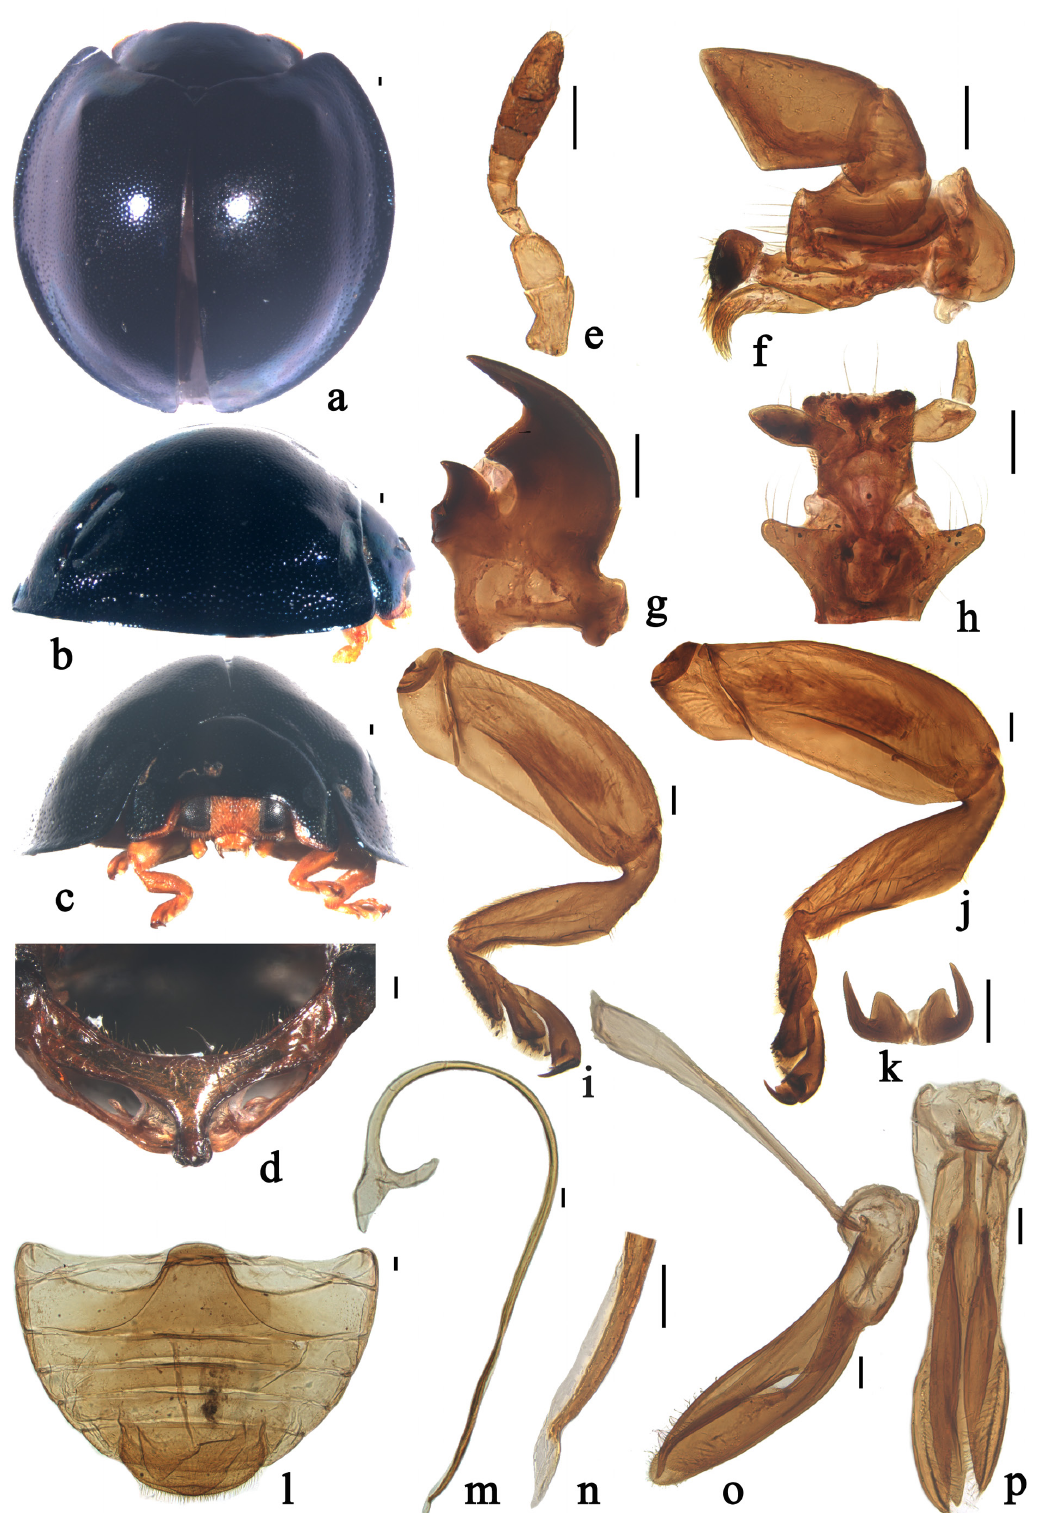
Fig. 3. Chilocorus nigricaeruleus Li & Wang sp. nov., holotype. a . Dorsal view. b . Lateral view. c . Frontal view. d . Prothorax. e . Antenna. f . Maxilla. g . Mandible. h . Labium. i . Front leg. j . Hind leg. k . Tarsal claw. l . Abdomen. m . Penis. n . Apex of penis. o . Tegmen, lateral view. p . Tegmen, ventral view. Scale bars: 0.1 mm. (SCAU (E)